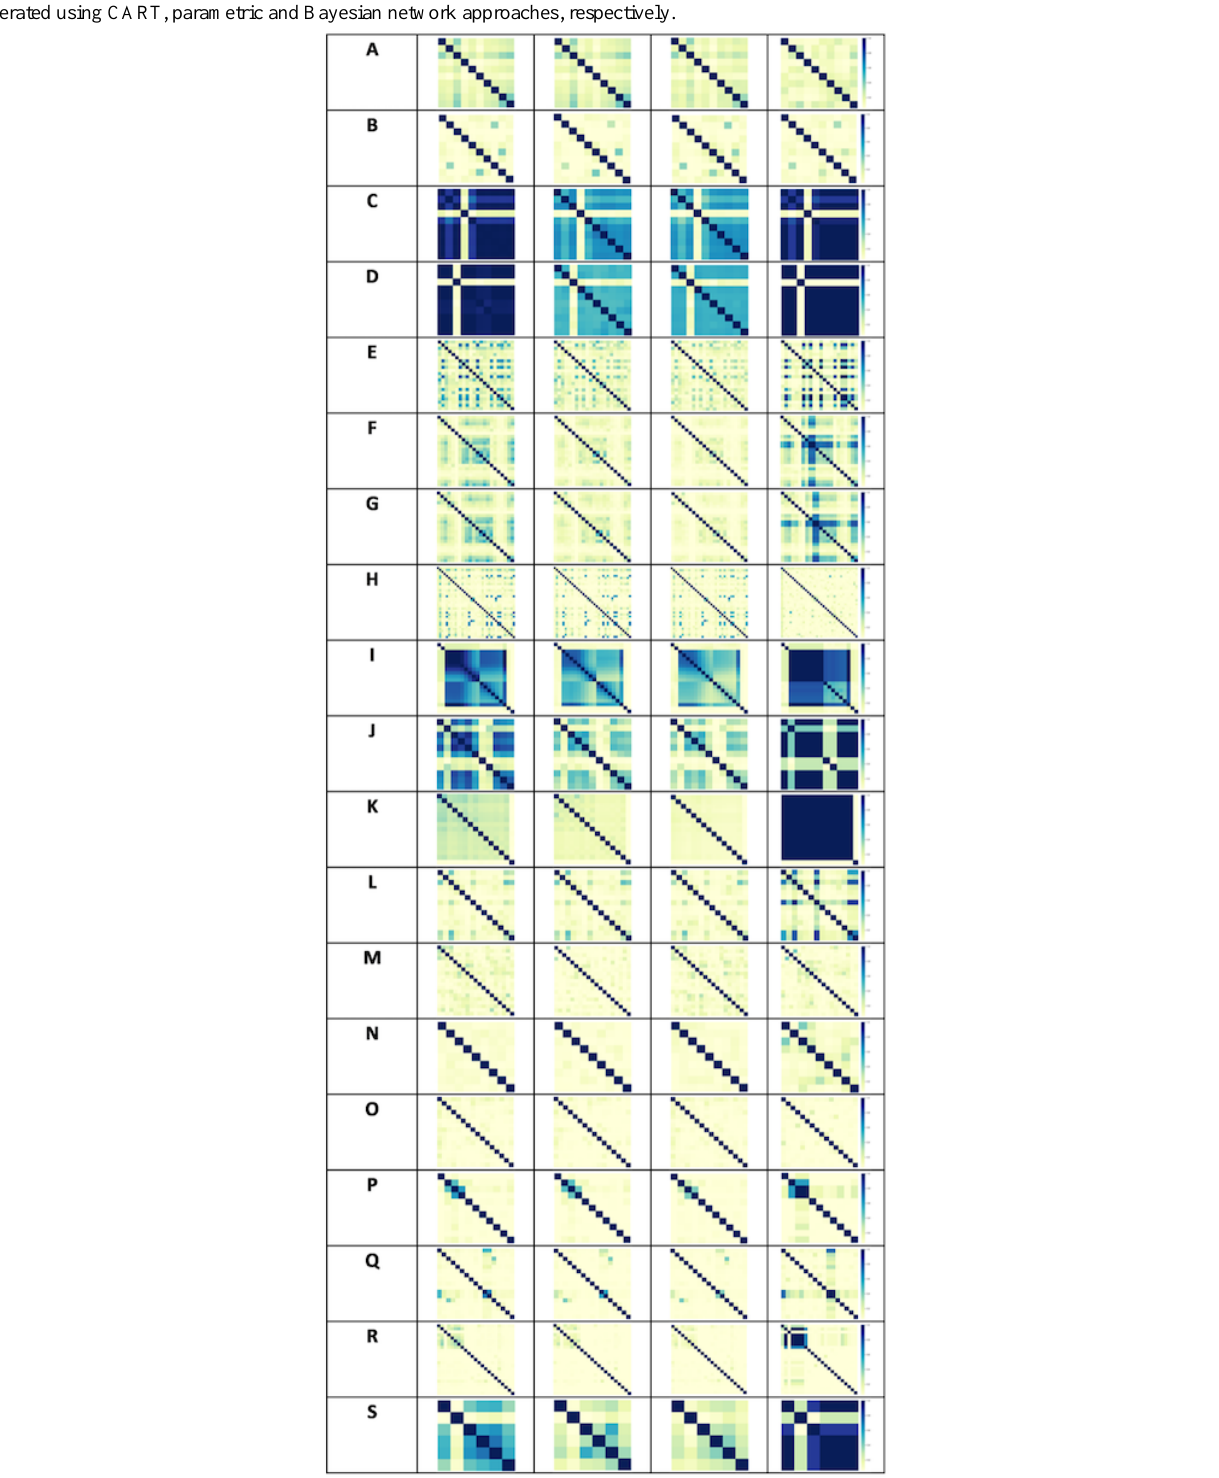
Figure 2. Pairwise mutual information for the real and synthetic datasets. These adjacency heat maps provide an efficient approach to visually determine whether the associations in the real datasets are similar to the associations in the corresponding synthetic datasets. Column 1 indicates the dataset, columns 2 indicates the pairwise mutual information for the real data, and columns 3-5 indicate the pairwise mutual information for synthetic datasets generated using CART, parametric and Bayesian network approaches,